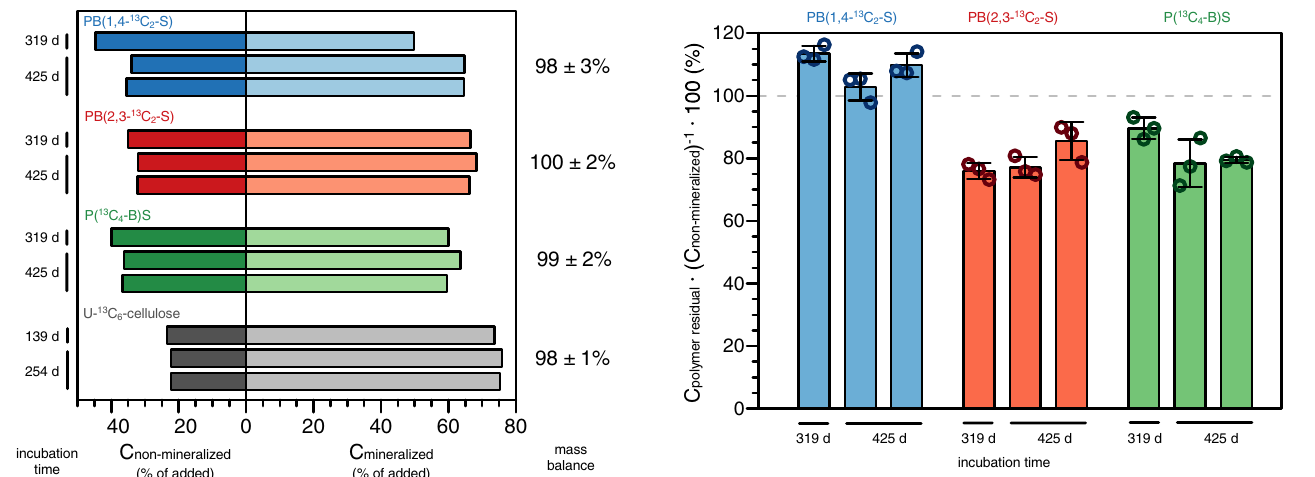
Fig.3|Massbalanceonpoly(butylenesuccinate)(PBS)-andcellulose-added 13 C over the soil incubations. Left side (darker shaded bars): total non-mineralized PBS- and cellulose-derived 13 C (i.e., C non-mineralized ) in the soils at the end of the incubationsshownforthethree 13 C-labelledPBSvariants(i.e.,PB(1,4- 13 C 2 -S),PB(2,3- 13 C 2 -S), and P( 13 C 4 -B)S; blue, red and green bars, respectively) and for 13 C-labelled cellulose (grey bars). Right side (lighter shaded bars): fi nal cumulative amounts of PBS- and cellulose- 13 C that had mineralized over the course of the soil incubations (replotted from Fig. 1b, f, respectively). Both C non-mineralized and C mineralized are expressed as percent of the amounts of PBS- 13 C and cellulose- 13 C that we initially addedtothesoilsattheonsetoftheincubations.Thevaluestotherightoftheplot correspond to the mass balance on added 13 C (i.e., the sum of C non-mineralized and C mineralized in percent of the amount of PBS- 13 C and cellulose- 13 C that we initially added to the soils at the onset of the incubations (quanti fi ed from results of all triplicate incubation bottles)). Incubations of PBS and cellulose were run in tripli- catesupto319and139daysandinduplicatesfrom319to425daysandfrom139to 254 days, respectively.